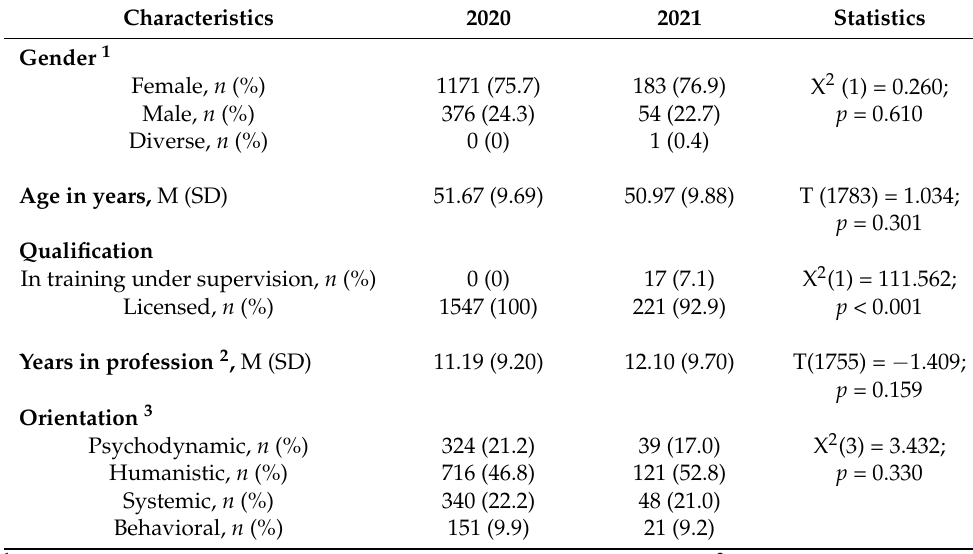
Table 1. Sociodemographic characteristics of the samples. Tests for independent samples were used as both surveys were